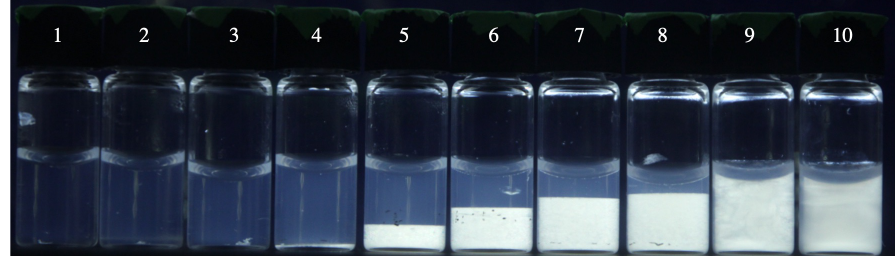
Figure 6. A series of CNC suspensions with increasing mass fraction w from left to right (the values, in wt.%, are indicated at the top of each vial), viewed between crossed polarizers after Earth gravity has separated the isotropic (dark, top) and cholesteric (bright, bottom) phases. Prior to taking the photo, all samples had been left undisturbed for 6 months. By quantifying the volume fraction of cholesteric to isotropic phase at each w , the coexistence regime of the phase diagram is mapped